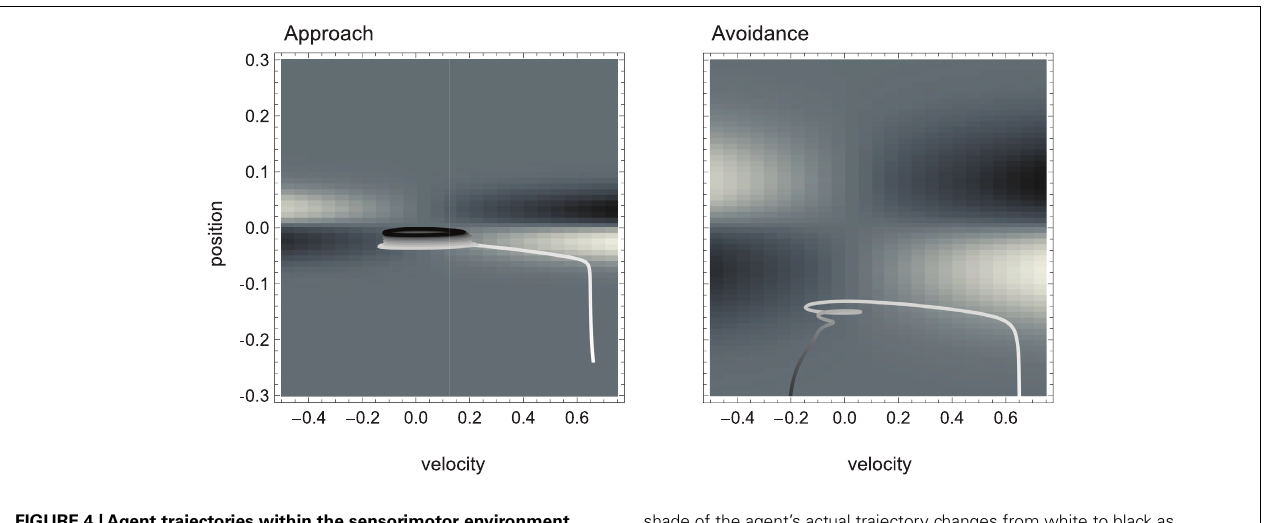
FIGURE 4 |Agent trajectories within the sensorimotor environment for approach and avoidance conditions .The SM environment is plotted here as a “top-view” of Figure 3 . On a background of gray areas indicating no sensory change, brighter points correspond to more positive and darker points to more negative change in sensory value.The